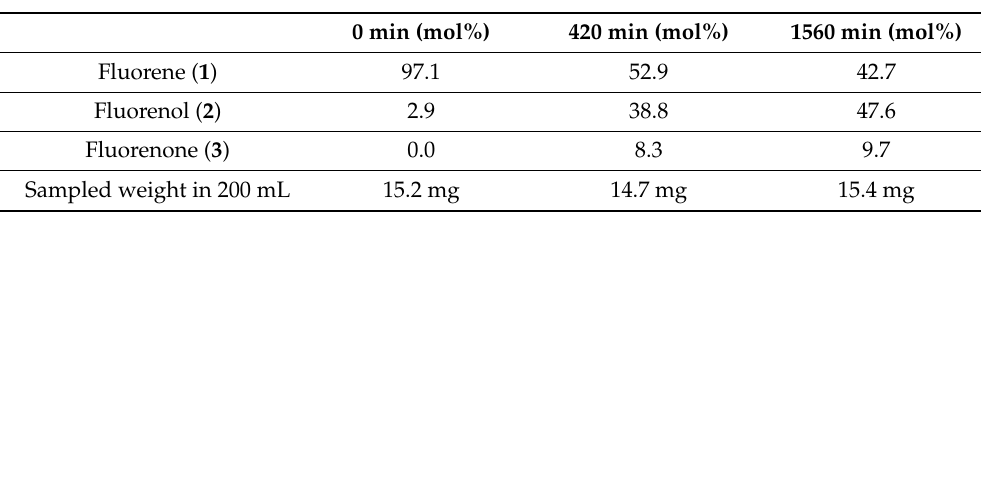
Table 1. NMR-derived molar percentages of different time point